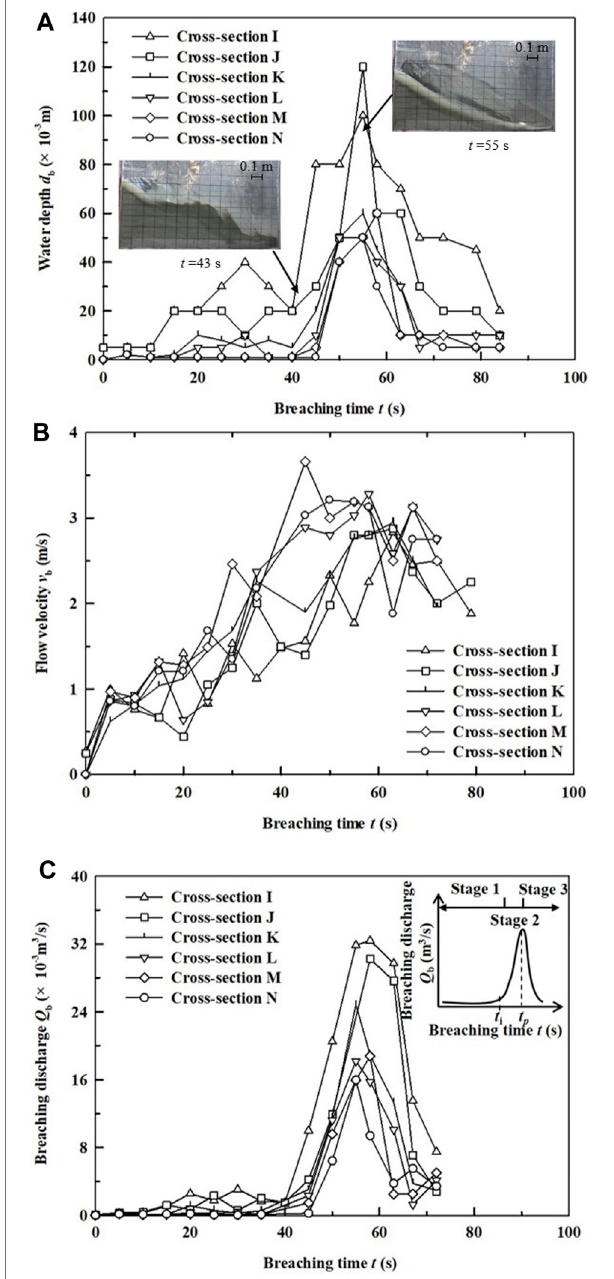
FIGURE6 | The evolution of the (A) depth (B) velocityand (C) discharge of breaching fl ow at different dam sections.